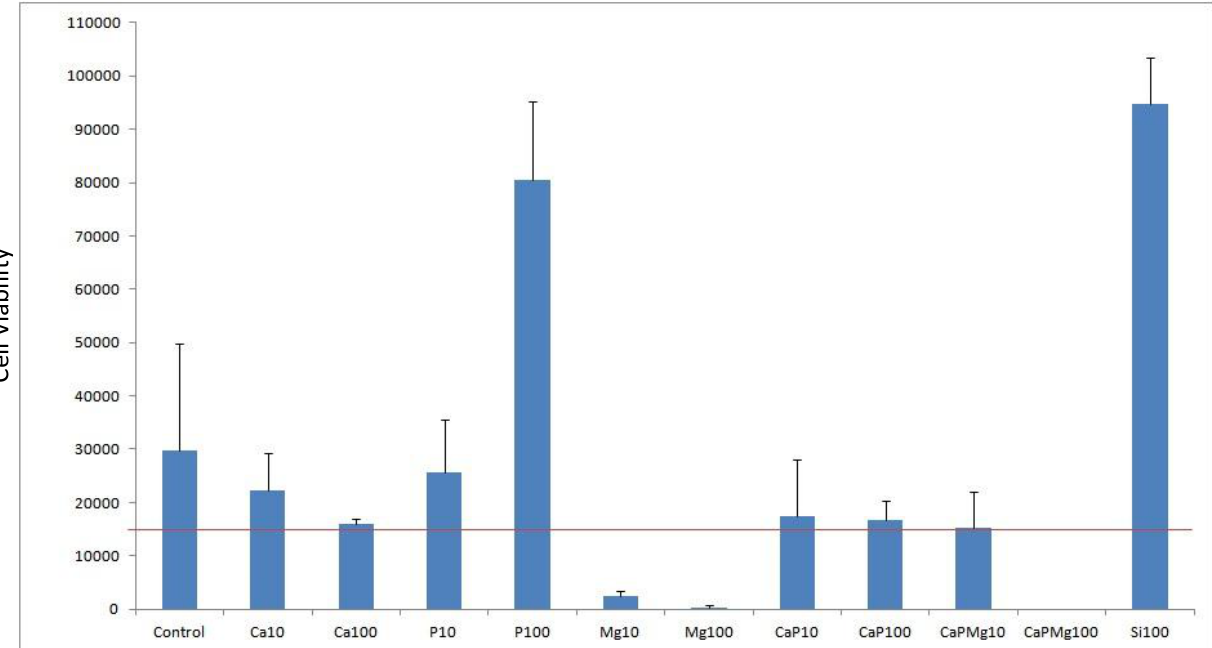
Figure 5. Plot of cell viability for doping alumina with Ca, P, Mg, Si as well as mixtures used with a concentration of 10% and 100%. Porous alumina without doping used as control specimen. Red horizontal line represents the seeded density of cells